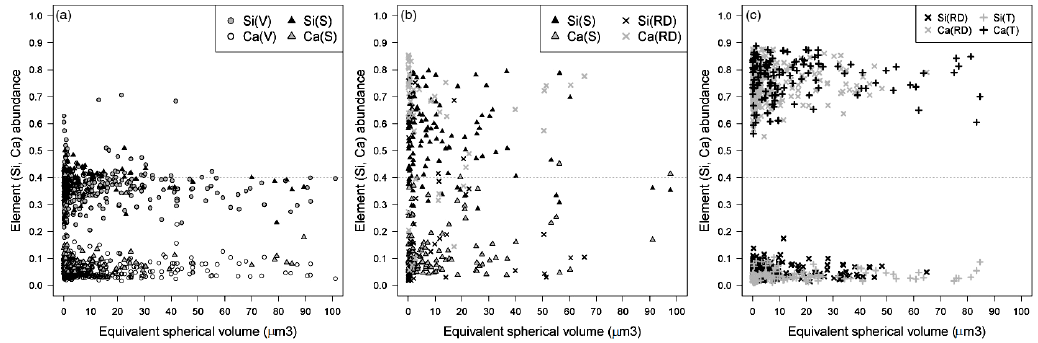
Figure 2. Ca and Si abundances of particles with highest PCA score in F1 (a) , F2 (b) , or F3 (c) , plotted vs. the particle equivalent spherical